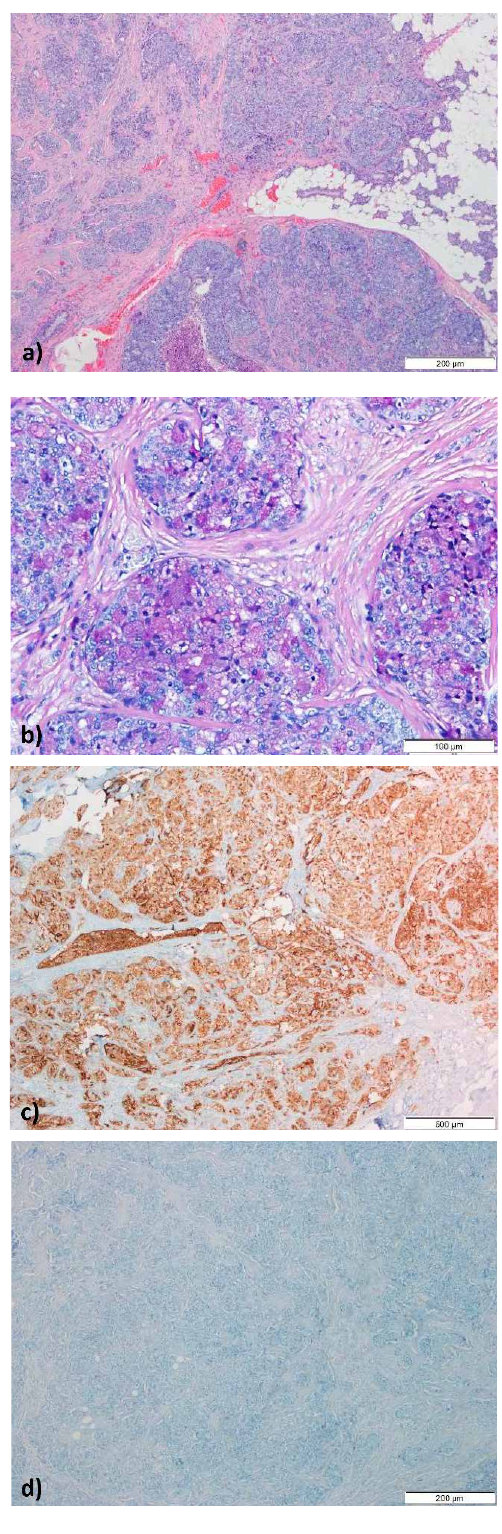
Figure 3: Histology–ACC: solid pattern and necrosis (H&E staining) (a); typical acinar cells with diastase-resistant PAS-positive granules (PAS-D staining) (b). The tumour cells showed strong immunor- eactivity for DOG1 (c), being negative for ACTH immunostaining (d). ACC: acinic cell carcinoma; H&E: hematoxylin and eosin; PAS: periodic acid–schiff; PAS-D: PAS–diastase; DOG1: discovered on GIST-1; ACTH: adrenocorticotropic